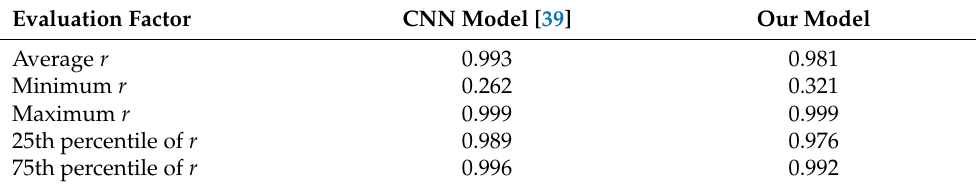
Figure 11. Distribution of Pearson’s correlation coefficient between target and estimated BP waveform. Table 4. Comparison of BP waveform prediction performance between our model and CNN